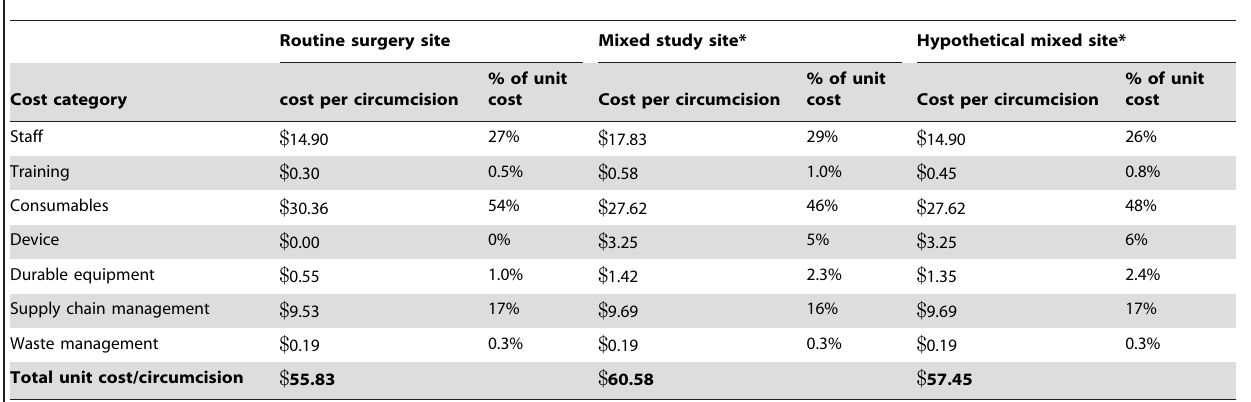
Table 1. Cost drivers for unit cost of different implementation models.